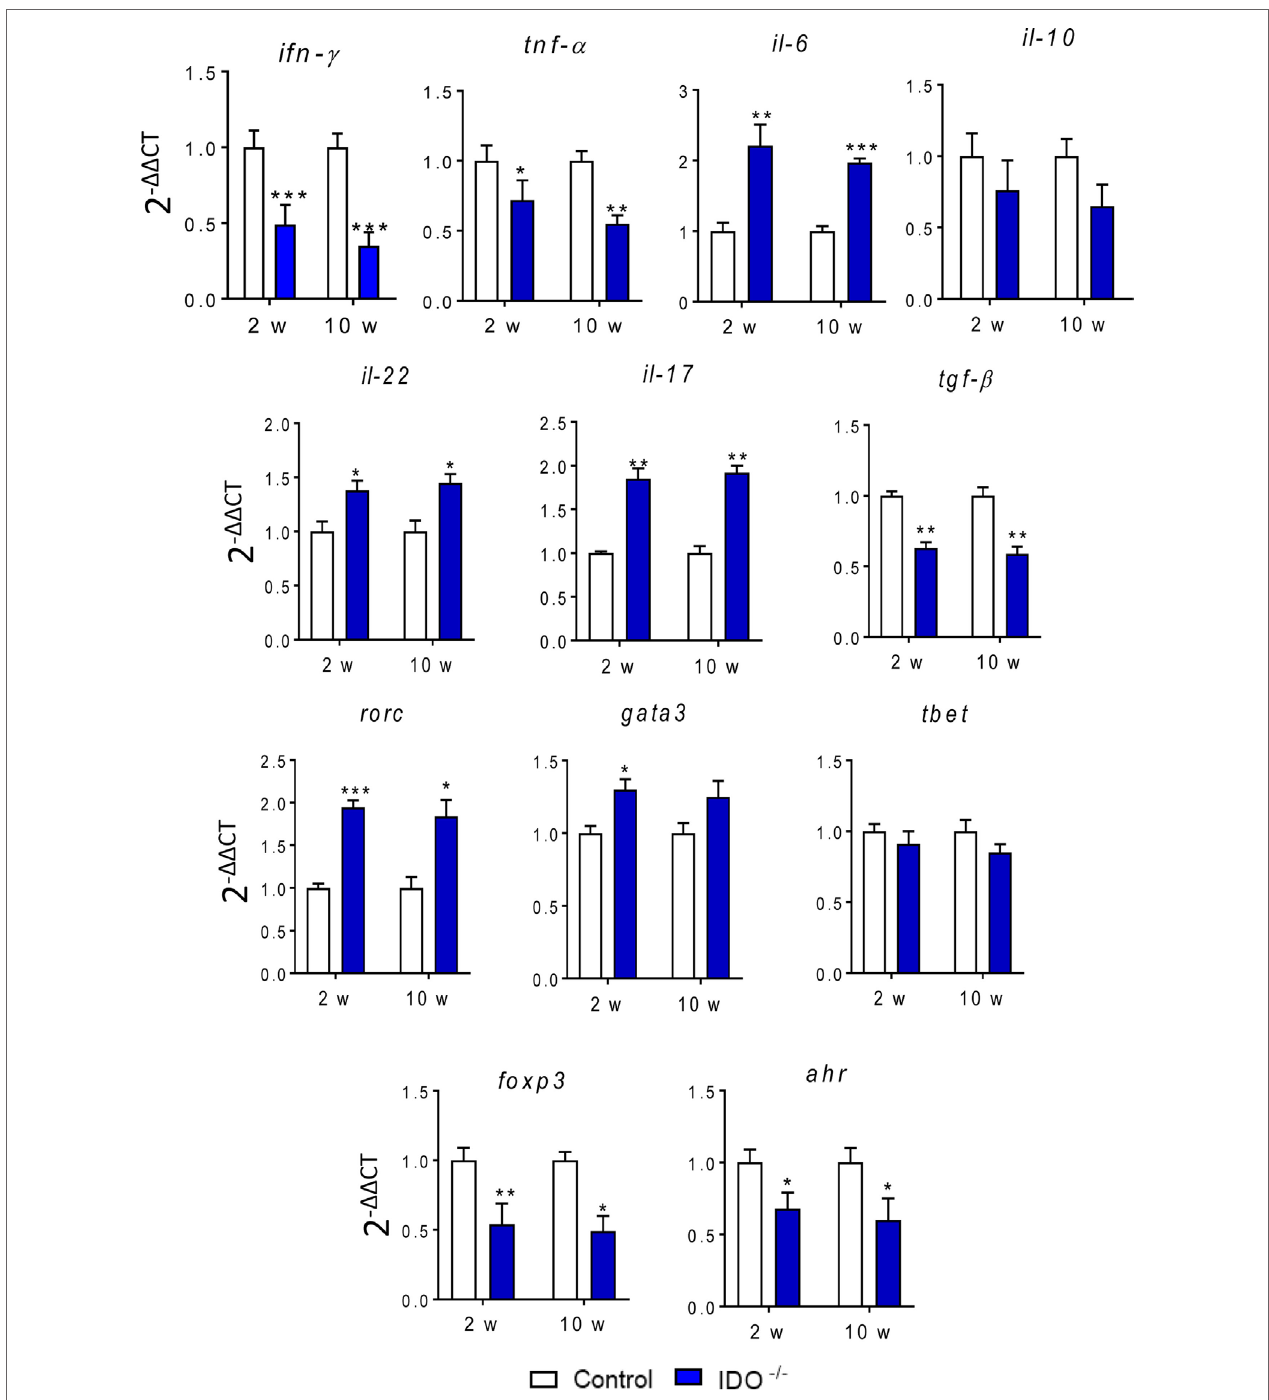
FigUre 8 | Indoleamine 2,3 dioxygenase-1 (IDO1) influences the gene expression of cytokines and transcription factors. Relative expression of mRNA for aryl hydrocarbon receptor (AhR), IFN- γ , TNF- α , IL-6, RORC, Tbet, GATA3, FoxP3, IL-10, TGF- β , IL-17, and IL-22 in whole lung cells of wild-type and IDO1 − / − mice after 10 weeks of Paracoccidioides brasiliensis infection. The level of gene transcription was determined by real-time PCR. Bars show mean ± SEM from at least four mice per group and are representative of three independent experiments (* p < 0.05; ** p < 0.01, and *** p <